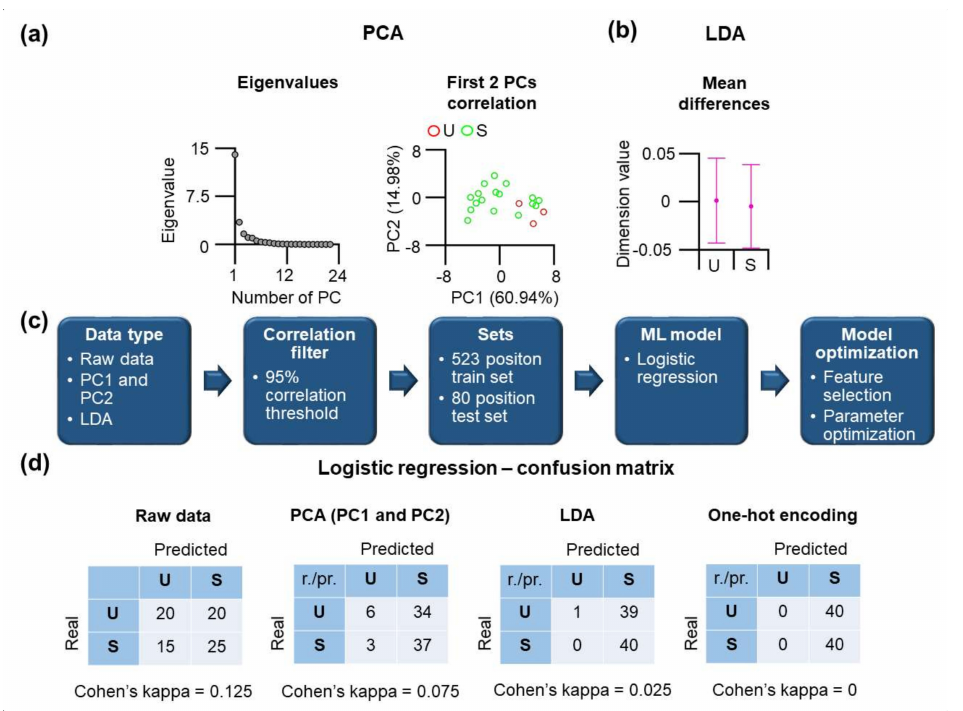
Figure 2. Application of PCA, LDA, and logistic regression methods to classify residues at 1 aa window size. ( a ) The PCA method. Eigenvalues of all PCs (left) and the plot (right) of PC1 (60.94% of total variance) versus PC2 (14.98% of the total variance). ( b ) Mean differences of dimension values between U and S classes were obtained by the LDA method. ( c ) The workflow for predictive machine learning model using logistic regression method at 1 aa window size. ( d ) Confusion matrix of logistic regression prediction using four different data types (raw data, first two PCs, LDA data, one-hot encoding